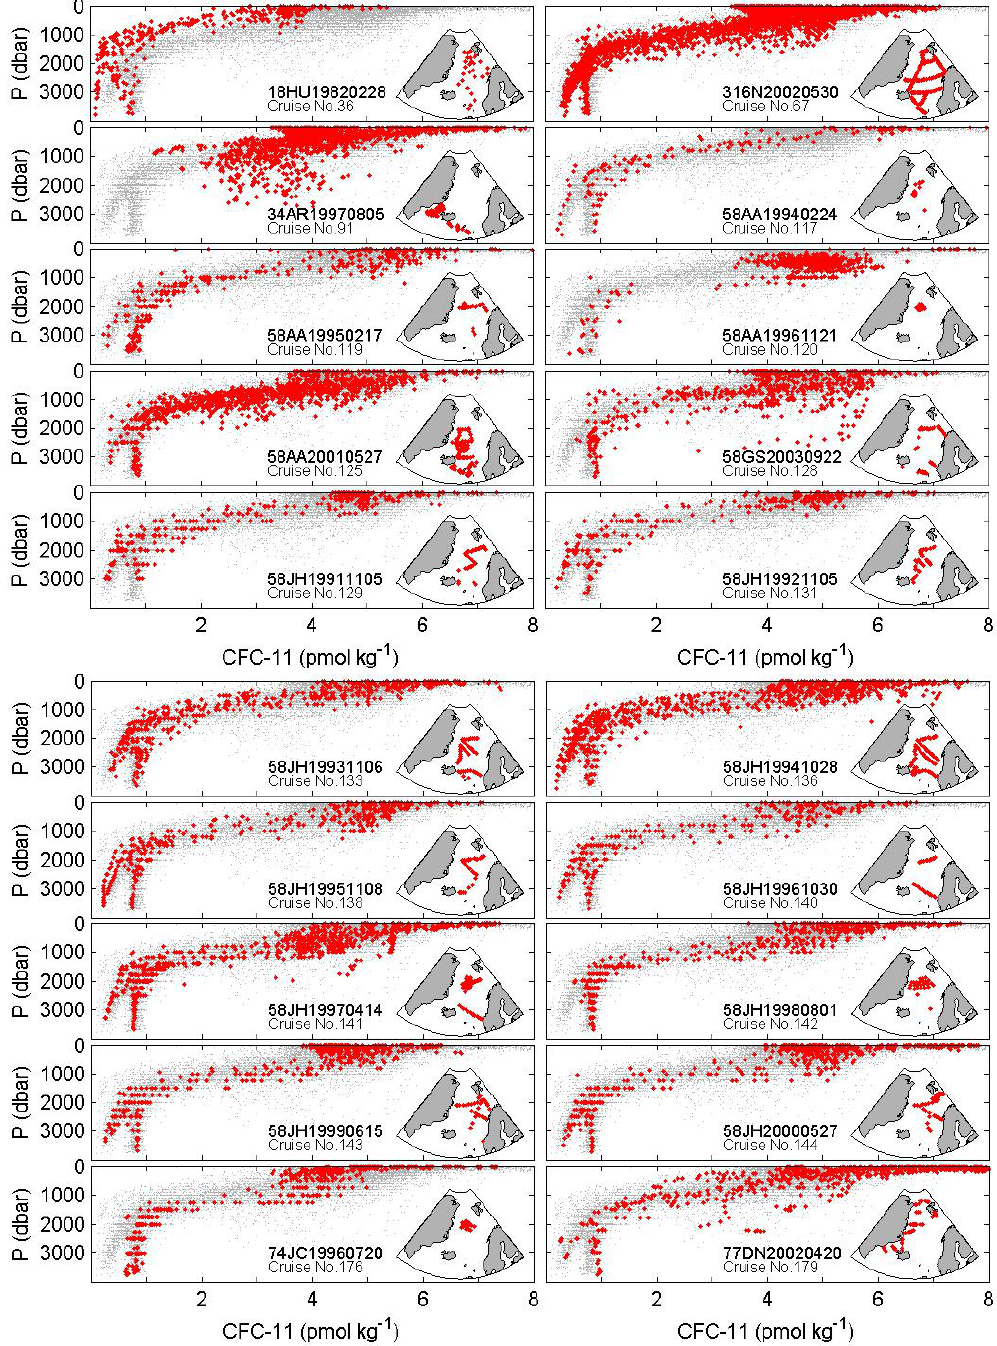
Figure 2. CFC-11 vs. pressure (dbar) for all Nordic Seas cruises in CARINA. The red dots mark data from each specific cruise, and the grey dots shows the CFC-11 data from all Nordic Seas CARINA cruises. The inserted map shows the specific cruise track.